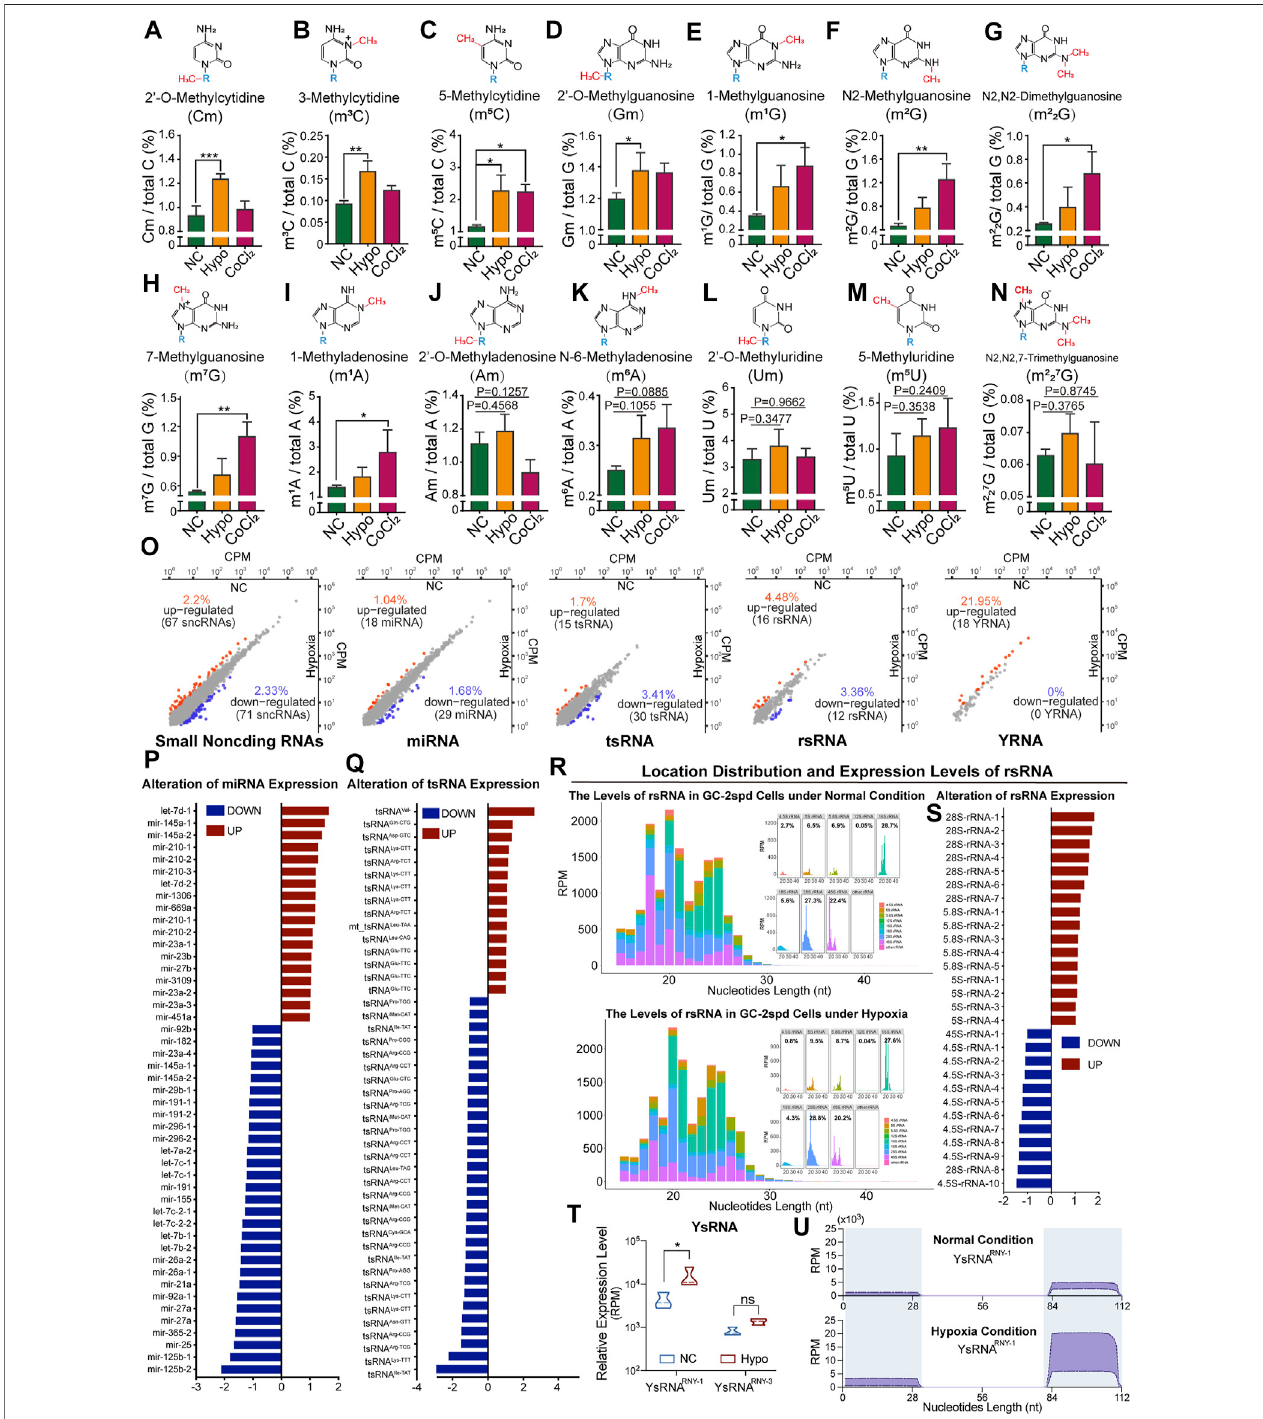
FIGURE 3 | Alterations in RNA modi fi cation levels and the expression levels of small non-coding RNAs in GC-2spd cells subjected to hypoxic conditions. (A – N) Relative levels of Cm, m 3 C, m 5 C, Gm, m 1 G, m 2 G, m 2 2 G, m 7 G, m 1 A, Am, m 6 A, Um, m 5 U, and m 2 27 G in 17 – 50 nt-sized RNA fragments in GC-2spd cells subjected to hypoxic treatment for 48 h or treated with 150 μ M CoCl 2 for 24 h (O – U) Sequencing analysis for differentially expressed small RNAs in GC-2spd cells subjected to hypoxic stress. (O) Alterations in four major small non-coding RNA (sncRNA) families in GC-2spd cells subjected to hypoxic stress: micro RNAs (miRNAs), tRNA- derived small RNAs (tsRNAs), rRNA-derived small RNAs (rsRNAs), and yRNA-derived small RNAs (ysRNAs). (P) Differentially expressed miRNAs. (Q) Differentially expressed tsRNAs. (R) Relative abundance and mapping locations of rsRNAs. (S) Differentially expressed rsRNAs. (T,U) Differentially expressed ysRNAs and their locationsinGC-2spdcellssubjectedtohypoxicstress.Statisticalanalysiswasperformedbyone-wayANOVAandDunnett ’ smultiplecomparisonstest.* p < 0.05,** p < 0.01, and *** p < 0.001, n = 3. Data in A – N are presented as mean ± SEM.